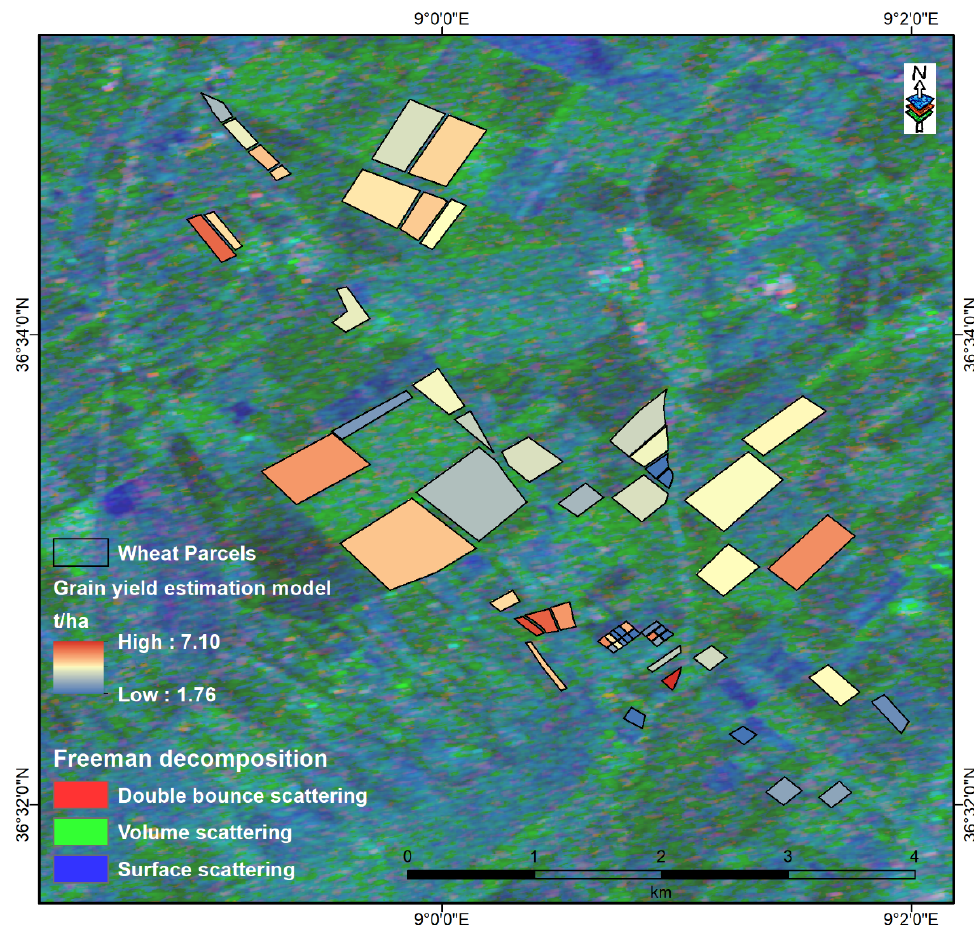
Figure 7. Wheat yield map obtained from the model; background image RGB = (Freeman_Dbl, Free- man_vol, Freeman_surf) derived from SAR image acquired on 14 April 2015 over Boussalem Re- gion.